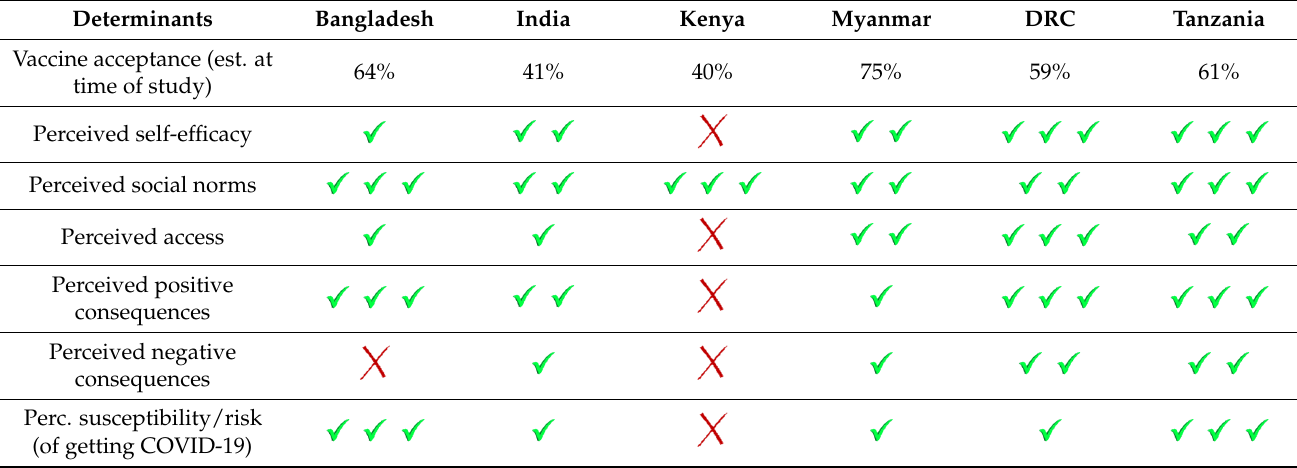
Table 1. Reference: degree of association between behavioural determinants and COVID-19-vaccine acceptance by country.